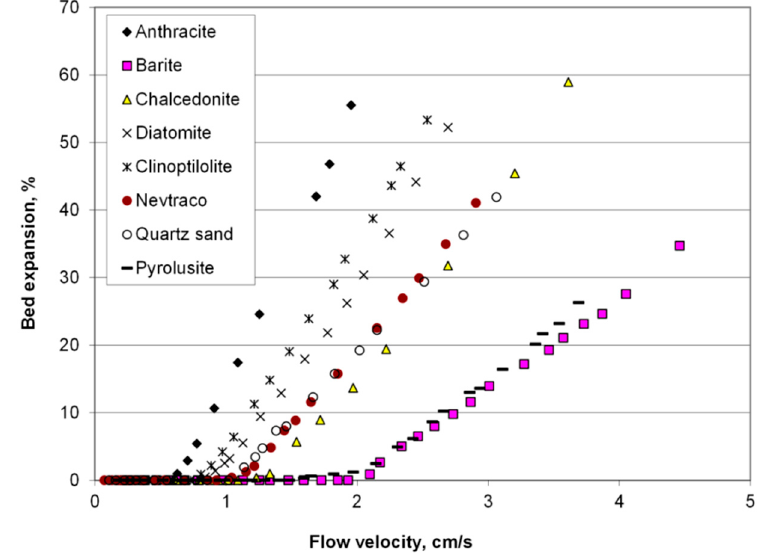
Figure 1. Expansion of mineral media in function of backwashing velocity, granulation of media 1.0–1.25 mm. Reprinted with permission from Ref. [71].